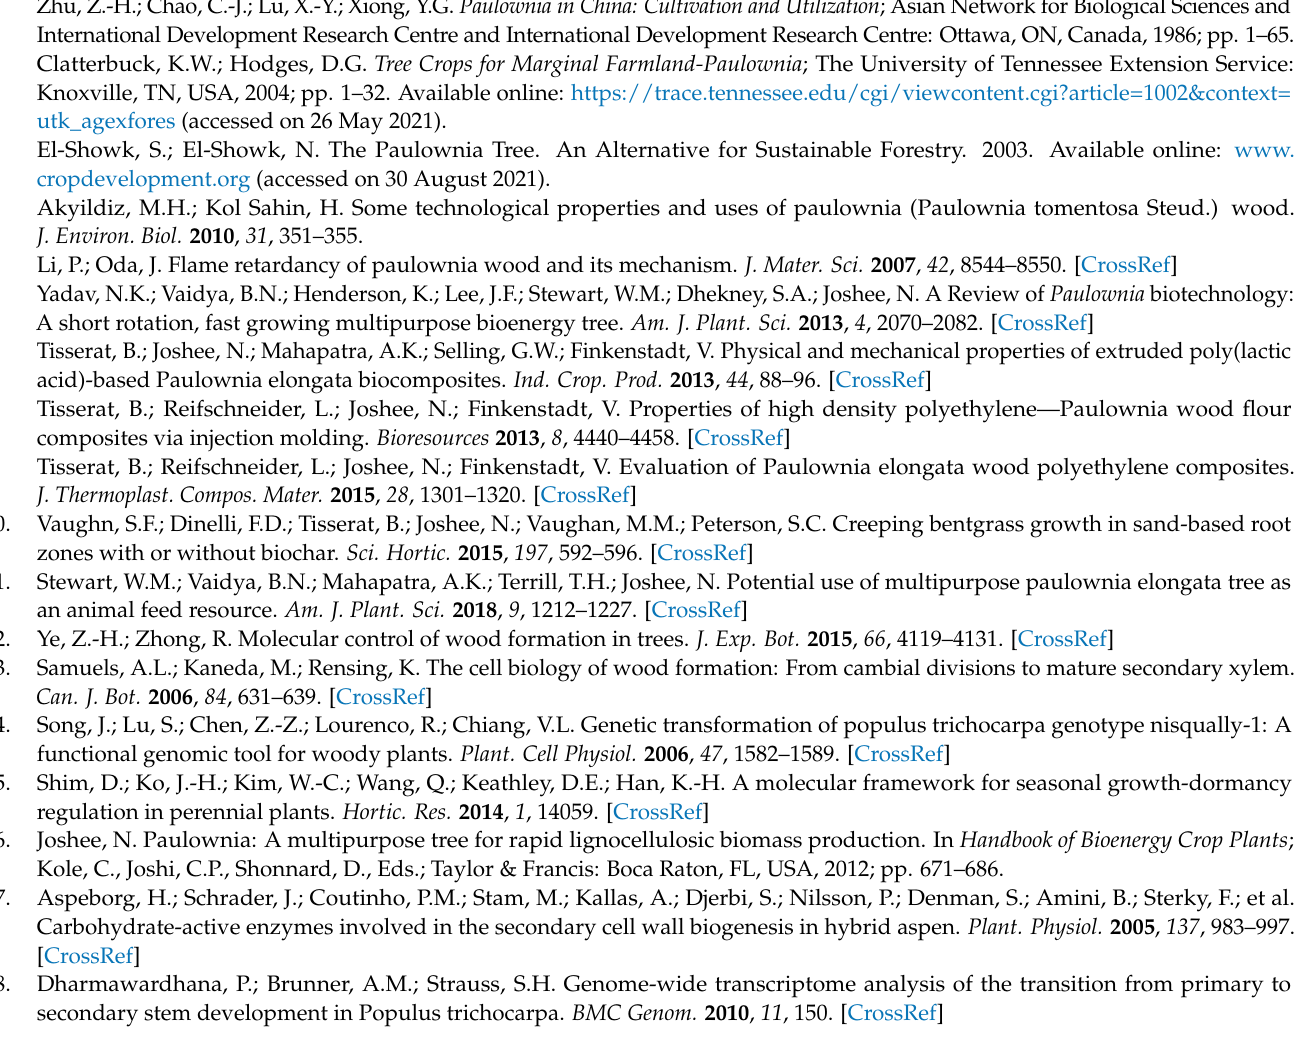
Table S1 Annotation BLASTX hits of unigenes in Nr database, Table S2 GO categories of unigenes, Table S3 COG function classsification of unigenes, Table S4 KEGG annotation of